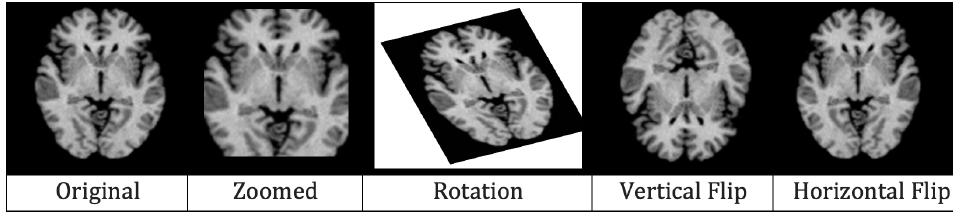
Figure 8. Effects of augmentation on